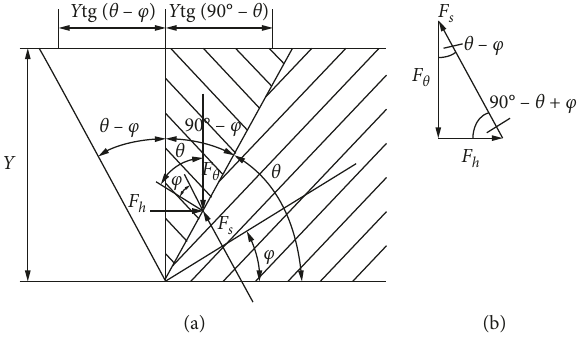
Figure 4: Analysis of the force of grains on the sliding surface. (a) Overall stress analysis. (b) Unit